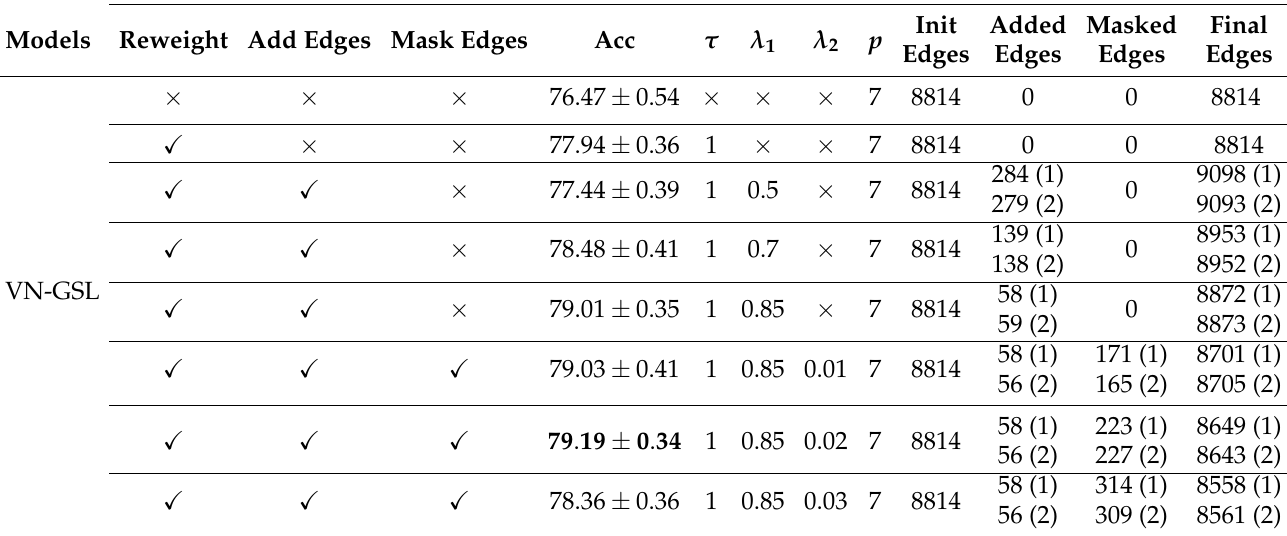
Table 4. Node classification mean accuracy ( % ) ± stdev for different components (we utilize a two-layer VN-GSL model, where the graph learned by the first layer is denoted as (1) and the graph learned by the second layer is denoted as